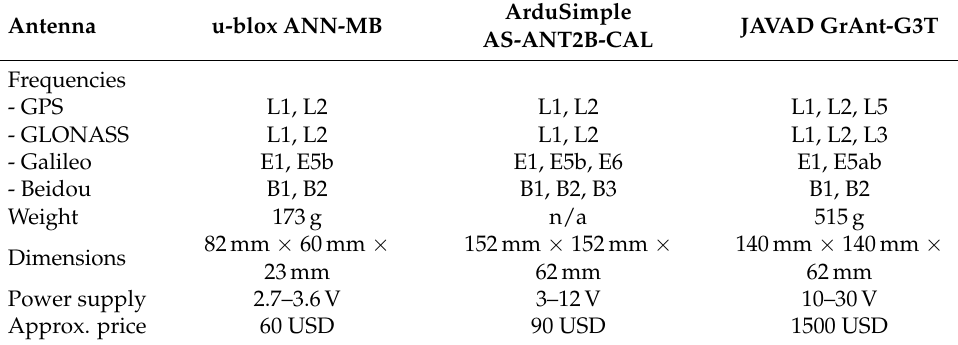
Table 2. Specifications of the GNSS antennas used for the experiments.